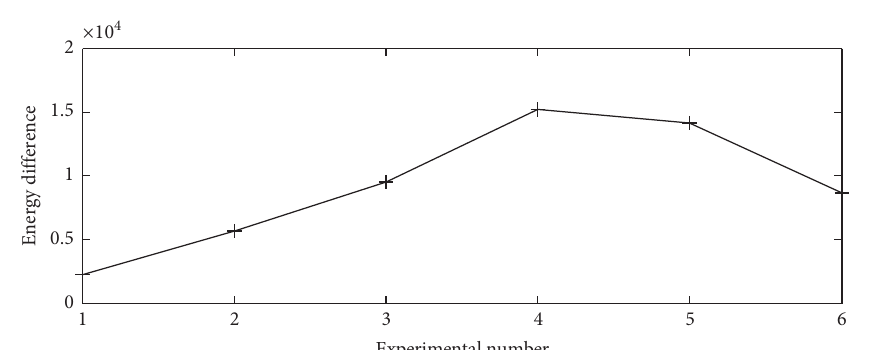
mesh in different input 1